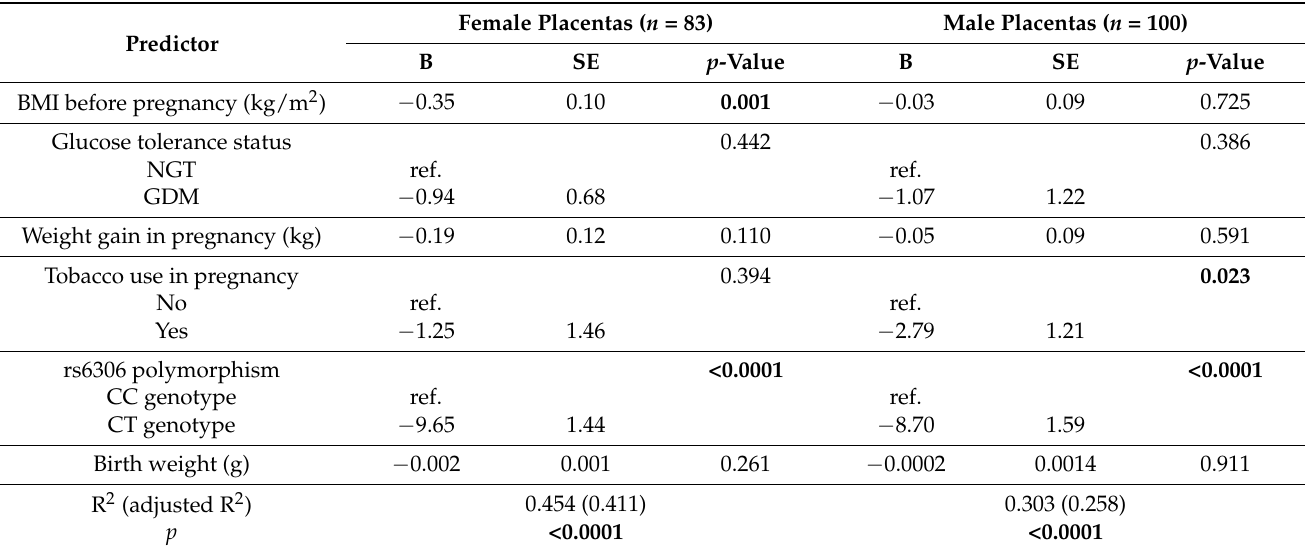
Table 3. Linear regression model of L3/L4 methylation (%) predictors in female and male placentas.